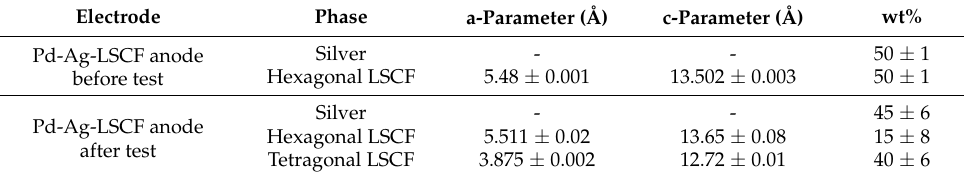
Figure 17. X-ray diffractograms collected from the Pd infiltrated Ag-LSCF anode surface after testing (LSCF PDF 04-019-6360, YSZ PDF 04-016-2113 and, Ag PDF 00-004-0783). Table 3. Phase parameters and phases found in Pd-Ag-LSCF anode before and after